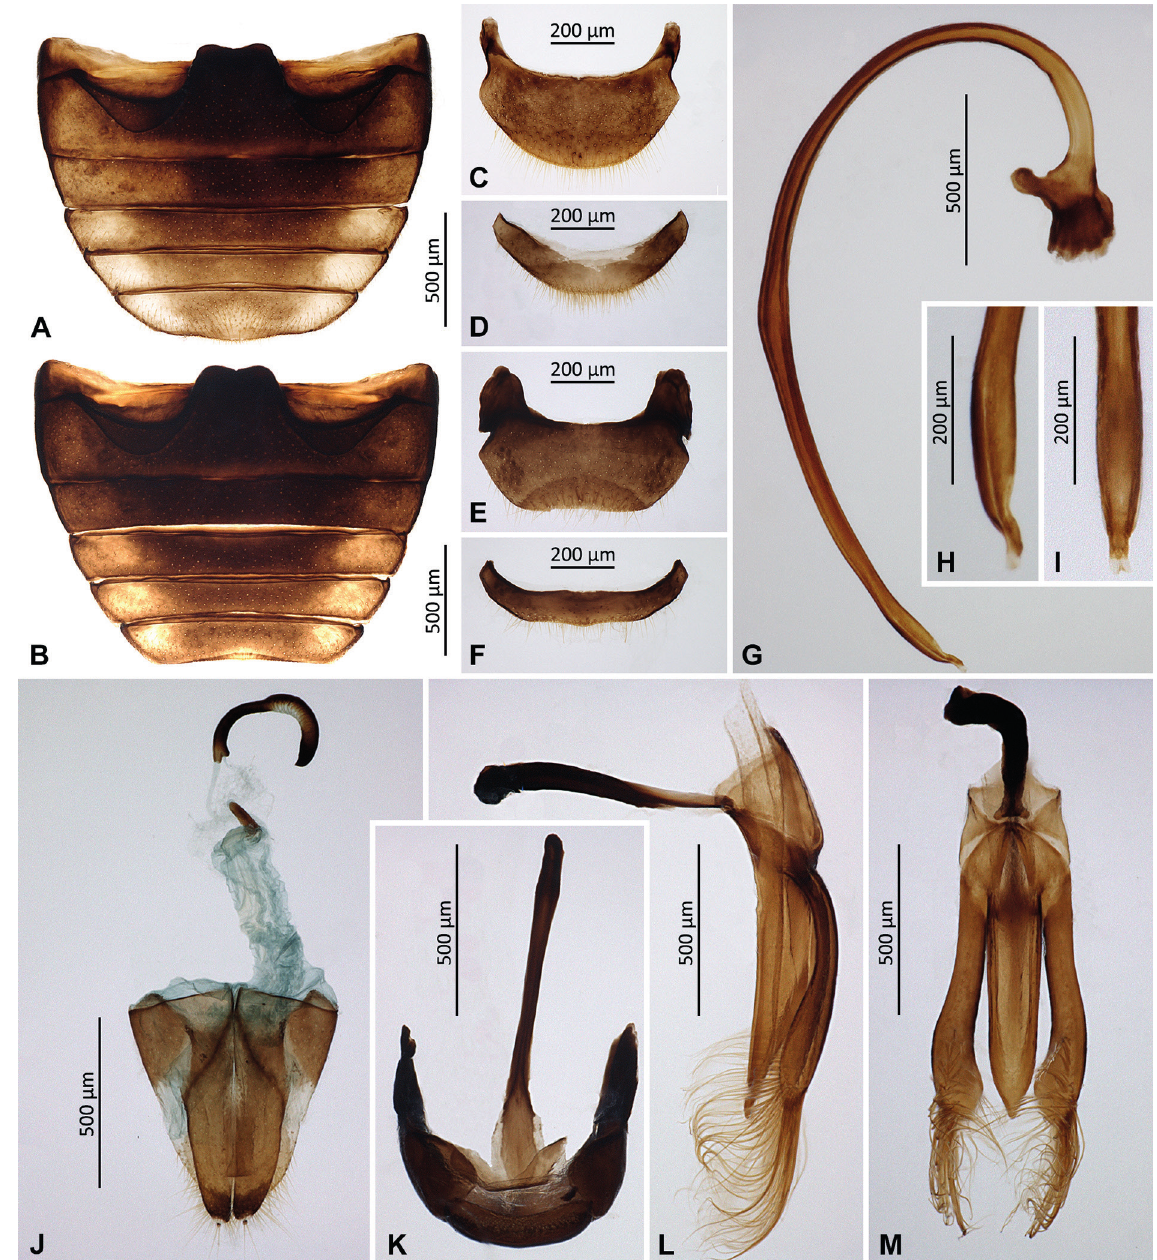
Fig. 6. Eupalea borowieci sp. nov. A . Paratype (MIZ), ♀, abdomen. B . Holotype (MNHW), ♂, abdomen. C . Paratype (MIZ), ♀, tergite VIII. D . Paratype (MIZ), ♀, ventrite 6. E . Holotype (MNHW), ♂, tergite VIII. F . Holotype (MNHW), ♂, ventrite 6. G . Holotype (MNHW), penis, lateral view. H . Holotype (MNHW), penis tip, lateral. I . Holotype (MNHW), penis tip, inner. J . Paratype (MIZ), ♀, genitalia, ventral. K . Holotype (MNHW), ♂, segments IX and X, dorsal view. L . Holotype (MNHW), tegmen, lateral view. M . Holotype (MNHW), tegmen, inner